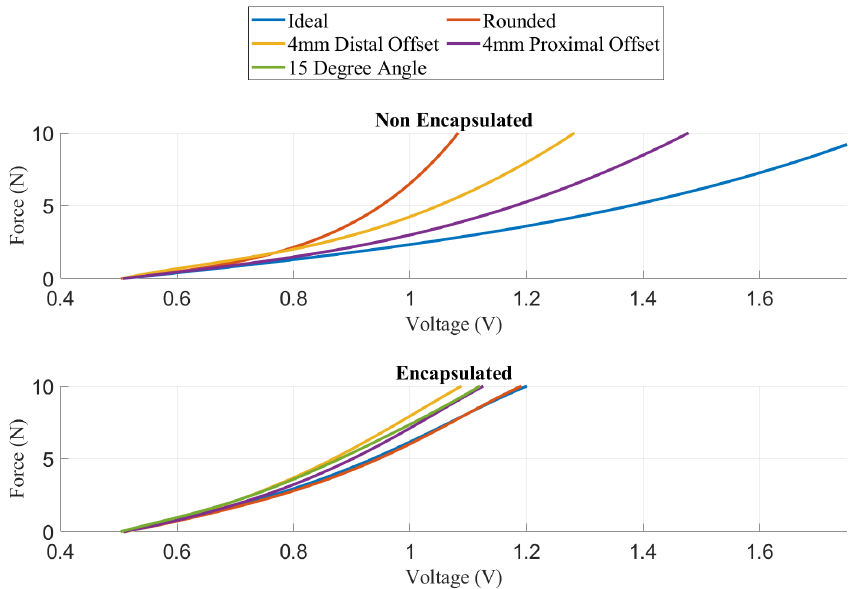
Figure 2. Summary of MSP grip force sensor accuracy under various loading conditions adapted from [45].